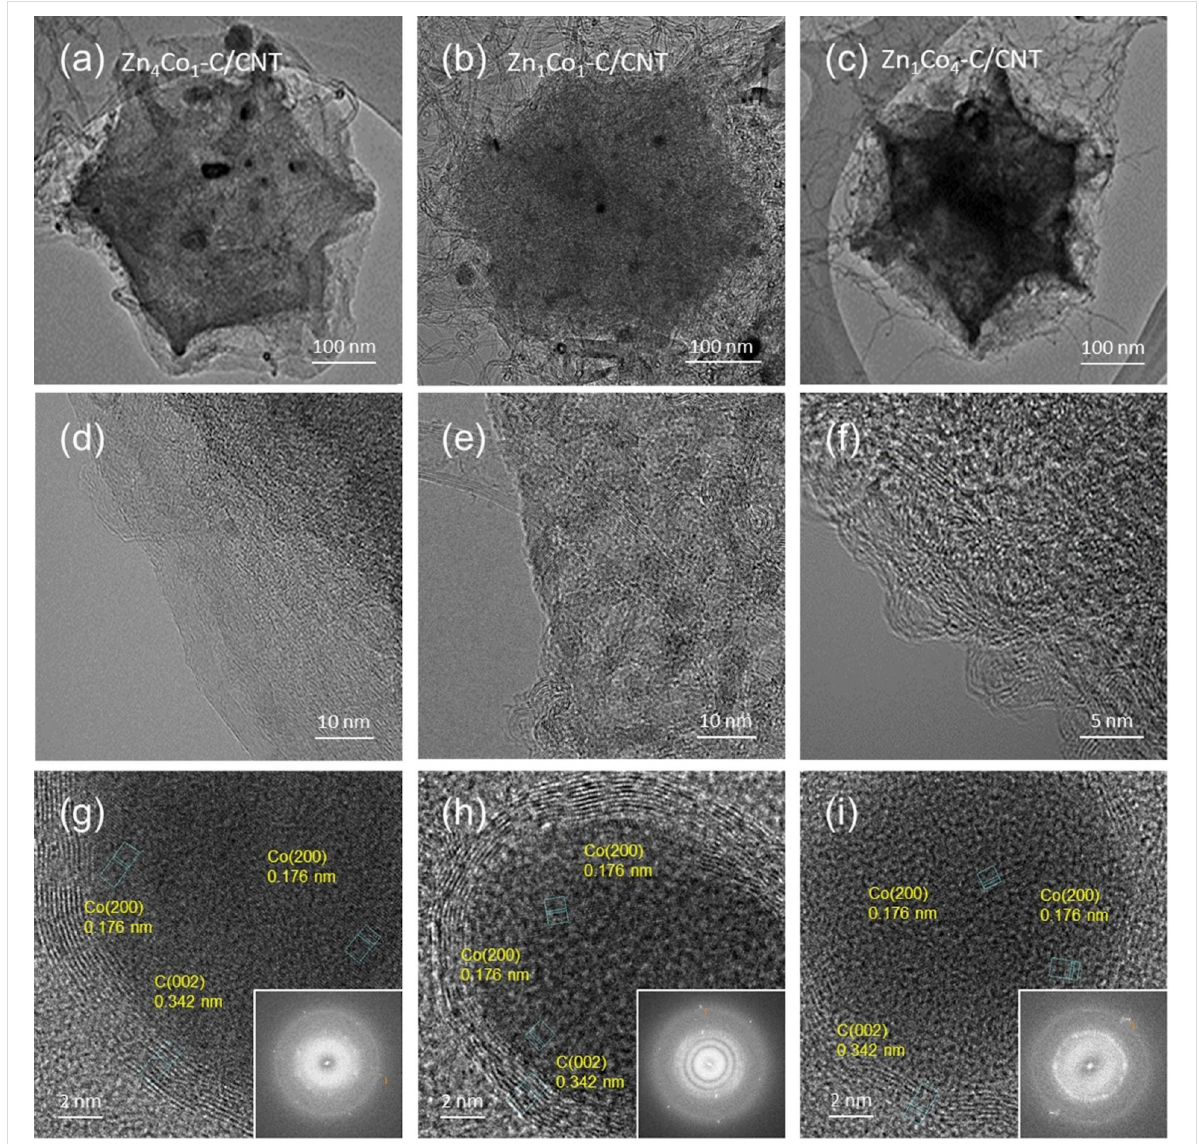
Figure 3: TEM images of (a, d, g) Zn 4 Co 1 –C/CNT, (b, e, h) Zn 1 Co 1 –C/CNT, (c, f, i) Zn 1 Co 4 –C/CNT. The insets in the bottom row are the correspond- ing selected area diffraction (SAED)